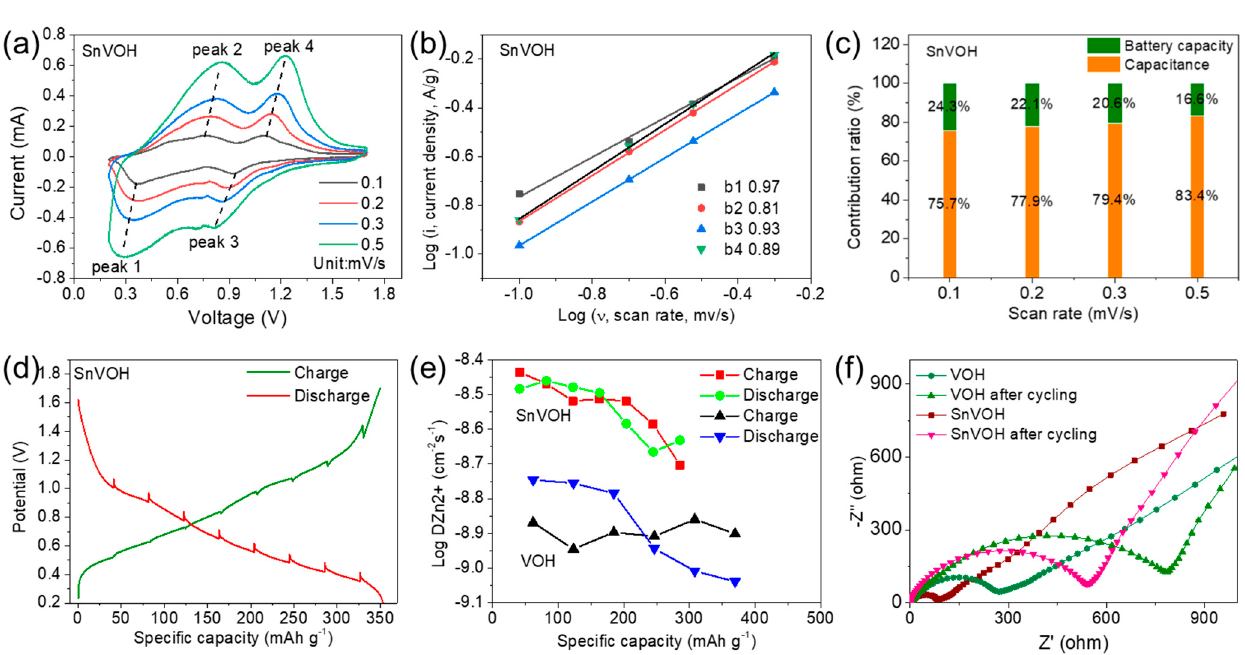
Figure 3. Kinetics study of VOH and SnVOH. ( a ) C–V curves of SnVOH electrode at different scan rates, ( b ) log (current) vs. log (scan rate) plots of four peaks in C–V curves during the cycles, and ( c ) capacity contribution ratios of battery type capacity and capacitance, ( d ) the discharge/charge curves in GITT measurement of SnVOH, ( e ) corresponding diffusivity coefficient of Zn 2+ in discharge and charge processes of SnVOH samples, and ( f ) electrochemical impedance profiles recorded for the VOH and SnVOH electrodes before electrochemical tests and after cycling at 5 A/g for 2500 times.